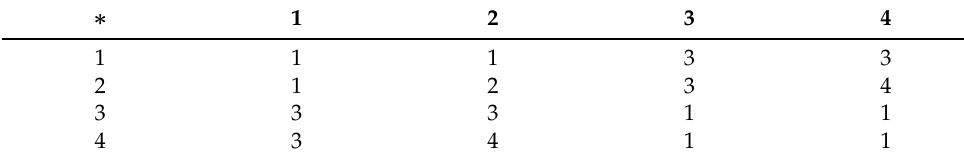
Table 4. A commutative CA-groupoid with quasi-cancellativity of Example 4.